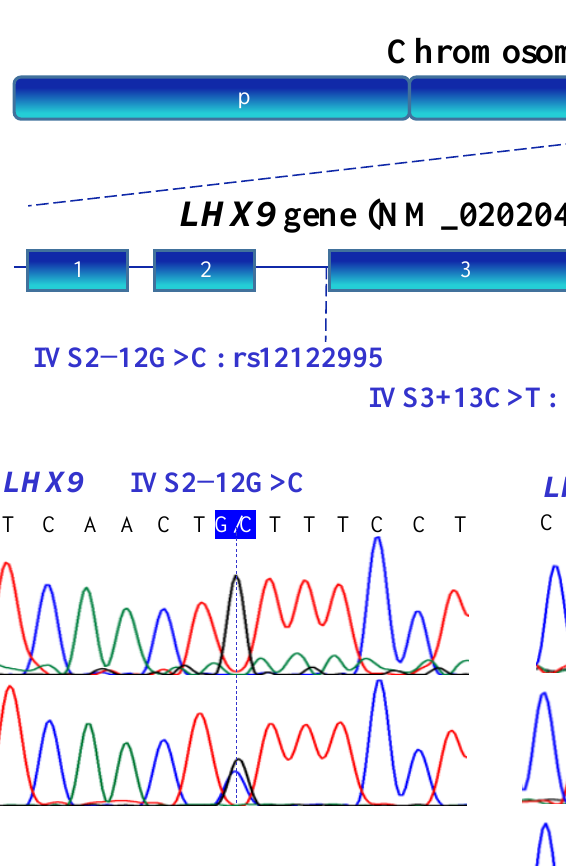
Figure 5. Partial nucleotide sequence of the human NR5A1 (NM_004959.5) gene and a structural diagram of its location on chromosome 9. Genotypic variants in the coding/non-coding regions are located in exon 4 and intron 4 (blue boxes), respectively. Exons are indicated with blue